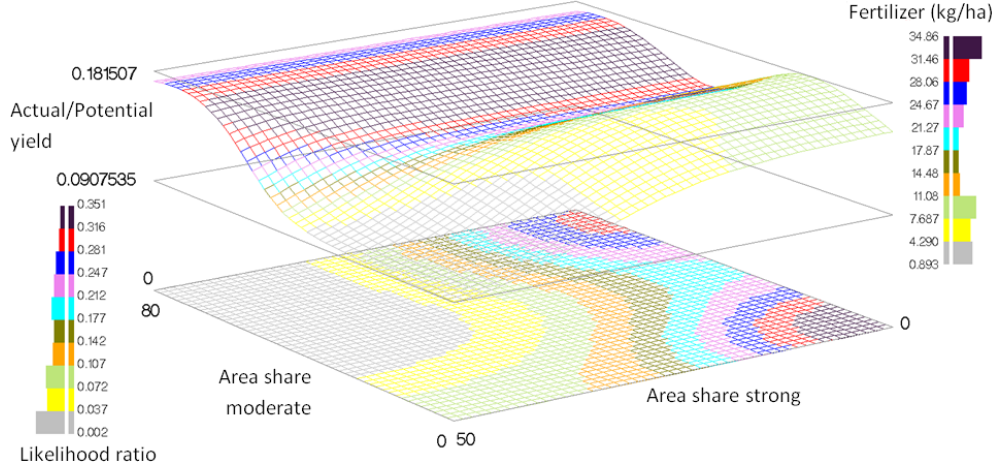
Figure 3. Yield ratio (actual / potential yield) against area share under moderate and strong degradation; covariates: fertilizer applications and likelihood